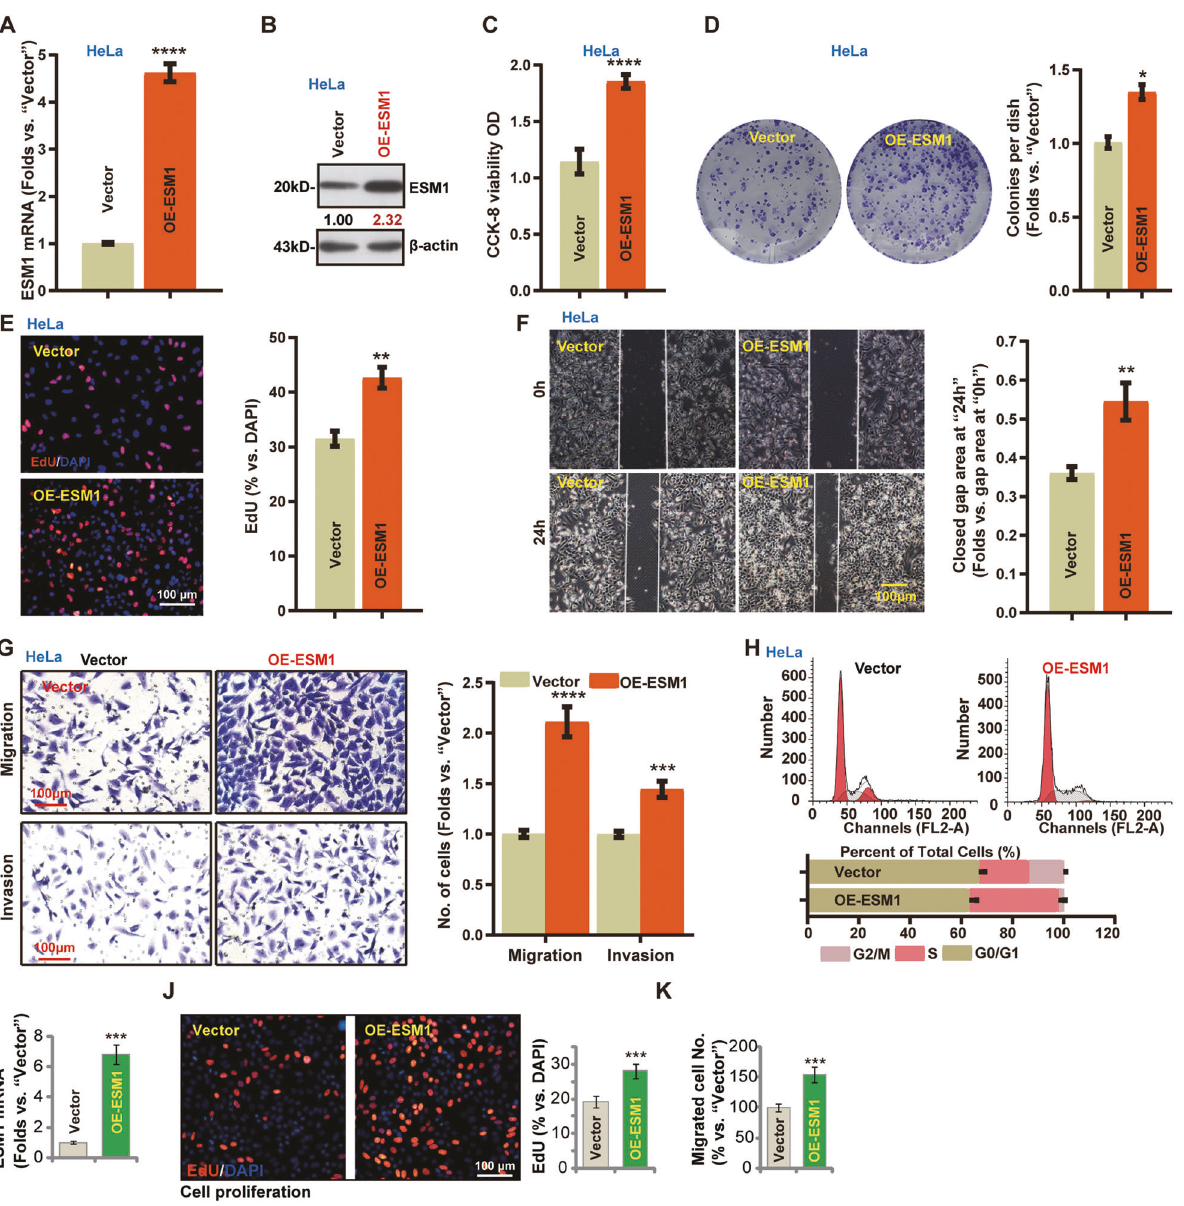
Fig. 3 Ectopic overexpression of ESM1 exerts signi fi cant promotion on cervical cancer cell progression. Lentiviral constructs encoding the full-length ESM1 cDNA ( “ OE-ESM1 ” ) and the empty vector ( “ Vector ” ) were established and were stably transduced to established cervical cancer cell lines (HeLa) ( A – H ) and primary cervical cancer cells ( “ priCC-1 ” ) ( I – K ). ESM1 overexpression was con fi rmed by qRT-PCR ( A and I ) and Western blotting ( B ) assays. Cell viability ( C ), colony formation ( D ), proliferation ( E and J ), in vitro cell migration and invasion ( F , G and K ), as well as cell cycle progression ( H ), were tested by the listed assays, with results quanti fi ed. The data were presented as mean ± standard deviation (SD, n = 3). * P < 0.05, ** P < 0.01, *** P < 0.001, **** P < 0,0001 vs. “ Vector ” cells. The experiments were repeated three times with similar results obtained. Scale bar = 100 μ